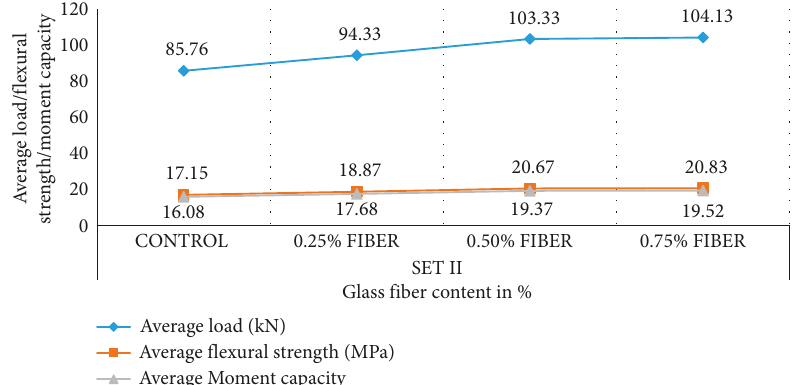
Figure 8: Average failure load, moment, and flexural strength of concrete beam samples after 28 days reinforced with glass fiber and reinforced